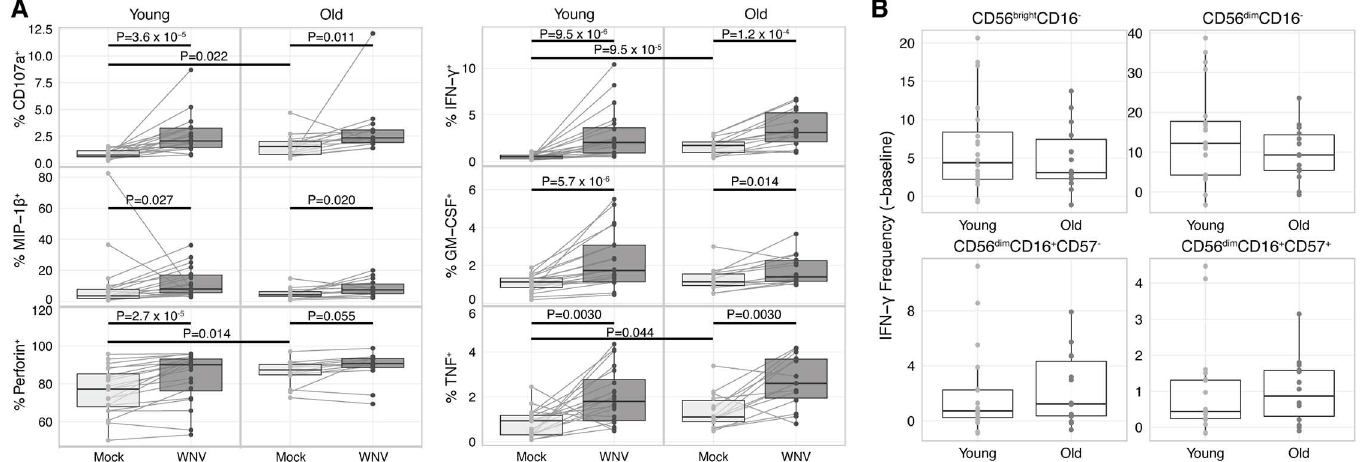
Fig 4. Robust functional response to WNV by NK cells from younger and older healthy subjects. PBMCs from young(n = 20) and old (n = 14) healthy subjects were incubatedwith medium alone (mock) or infected with WNV (MOI = 1) for 24 h. (A) Total NK cells from mock and WNV-infected groupsof each WNV subject were comparedby mass cytometry for surface expressionof CD107a and productionof production of MIP-1 β , perforin, IFN- γ , GM-CSF, and TNF. Mock-WNV comparisons, pairedWilcoxon tests. Mock-mock and WNV-WNV comparisons, Mann-Whitney U tests. (B) Four NK cell subsets from young and old healthysubjects were comparedfor inductionlevel of IFN- γ by subtractingbaselineof the mock group from the WNV-infected group. Mann-Whitney U